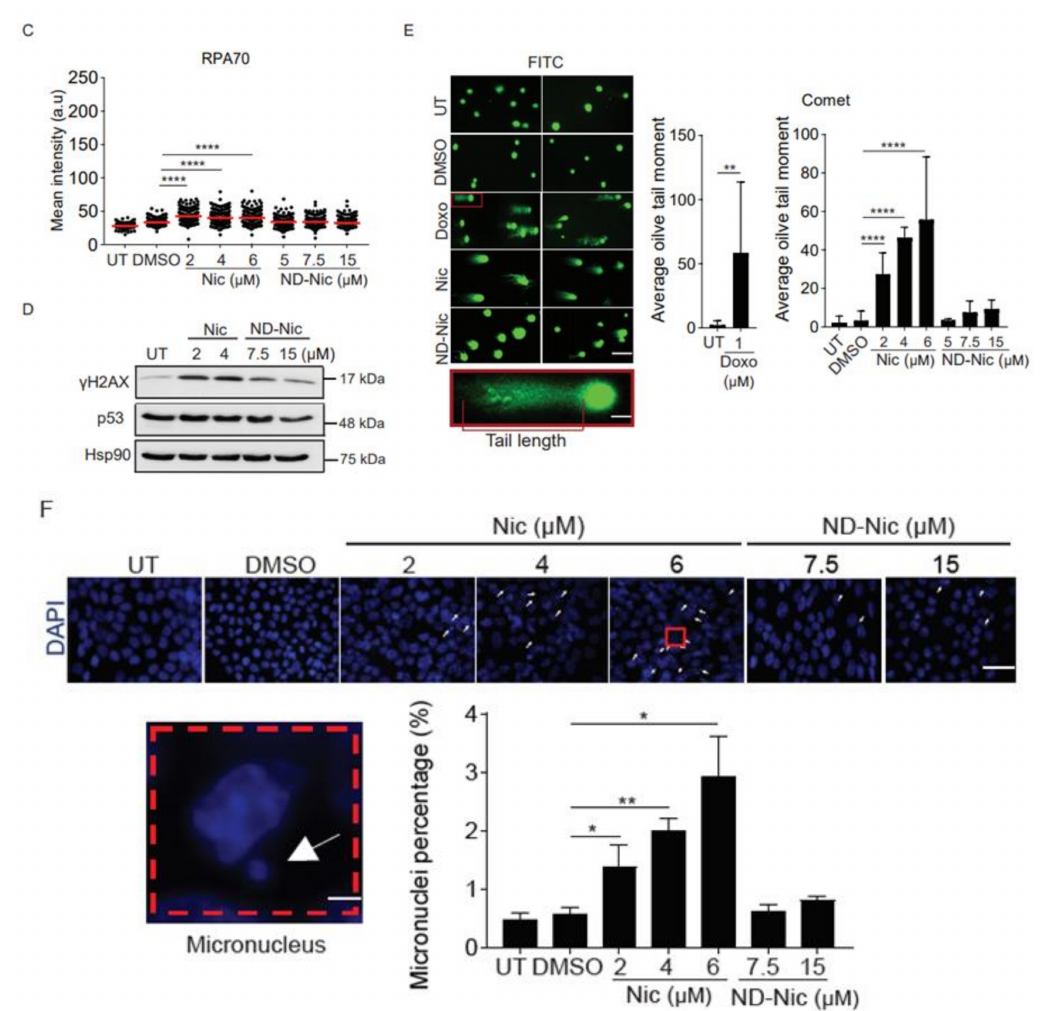
Figure 3. Elimination of the aniline 4 (cid:48) -NO 2 group attenuated genome-wide DNA damage induced by niclosamide. Represen- tative immunofluorescence images and quantification of DNA damage markers, ( A ) γ H2AX, ( B ) pRPAS4S8, ( C ) and RPA70 in human colon carcinoma HCT116 cells, untreated (UT) or treated with 0.4% DMSO, Nic (2, 4, and 6 µ M) and ND-Nic (5, 7.5, and 15 µ M) for 48 h. White scale bar at 50 µ m. Error bars represent ± SD of at least 3 independent experiments. t -test was used to determine significance (****, p < 0.0001). ( D ) Western Blots of γ H2AX, p53, and Hsp90 (loading control) in HCT116 cells, untreated (UT) or treated with Nic (2 and 4 µ M) and ND-Nic (7.5 and 15 µ M) for 48 h. ( E ) Left: Representative fluorescent images of Vista green stained DNA obtained from comet assay in untreated (UT), positive control doxorubicin (Doxo), 0.4% DMSO, Nic, and ND-Nic treated HCT116 cells. Bottom: A magnified image of comet tail emerging from a nucleus. Tail length is indicated in red. Right: Olive tail moment (OTM), calculated as (tail length-head length) x% tail DNA quantifies the extent of breaks detected by the comet assay in HCT116 cells, untreated (UT) or treated with 1 µ M Doxo (24 h), DMSO, Nic (2, 4, and 6 µ M) and ND-Nic (5, 7.5, and 15 µ M) for 48 h. White scale bar at 50 µ m. Error bars represent ± SD of at least 3 independent experiments. t -test was used to determine significance (** = p < 0.01 and **** = p < 0.0001). Average olive tail moment values are: UT (2), 1 µ M Doxo (58), DMSO (3), Nic 2 µ M (27), 4 µ M (46), and 6 µ M (55), ND-Nic 5 µ M (3.5), 7.5 µ M (7), and 15 µ M (9). ( F ) Representative images of DAPI stained nuclei in untreated (UT), 0.4% DMSO, Nic, and ND-Nic treated HCT116 cells for 48 h. White arrow indicates micronuclei. Bottom left: White arrow indicates a micronucleus formed adjacent to a parent nucleus. Bottom right: Percentage of micronuclei detected in HCT116 cells, untreated (UT) or treated with DMSO, Nic (2, 4, and 6 µ M) and ND-Nic (7.5 and 15 µ M) for 48 h. White scale bar at 50 µ m. Error bars represent ± SD of at least 3 independent experiments. t -test was used to determine significance (* = p < 0.05 and ** = p < 0.01). To further determine if niclosamide induces the formation of DNA lesions, we em- ployed comet assay. Comet assay enables the measurement of DNA strand breaks at